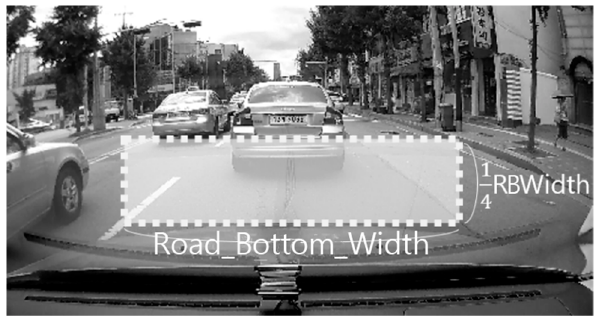
Figure 6. Predefined ROI when failing to detect the car shadow.